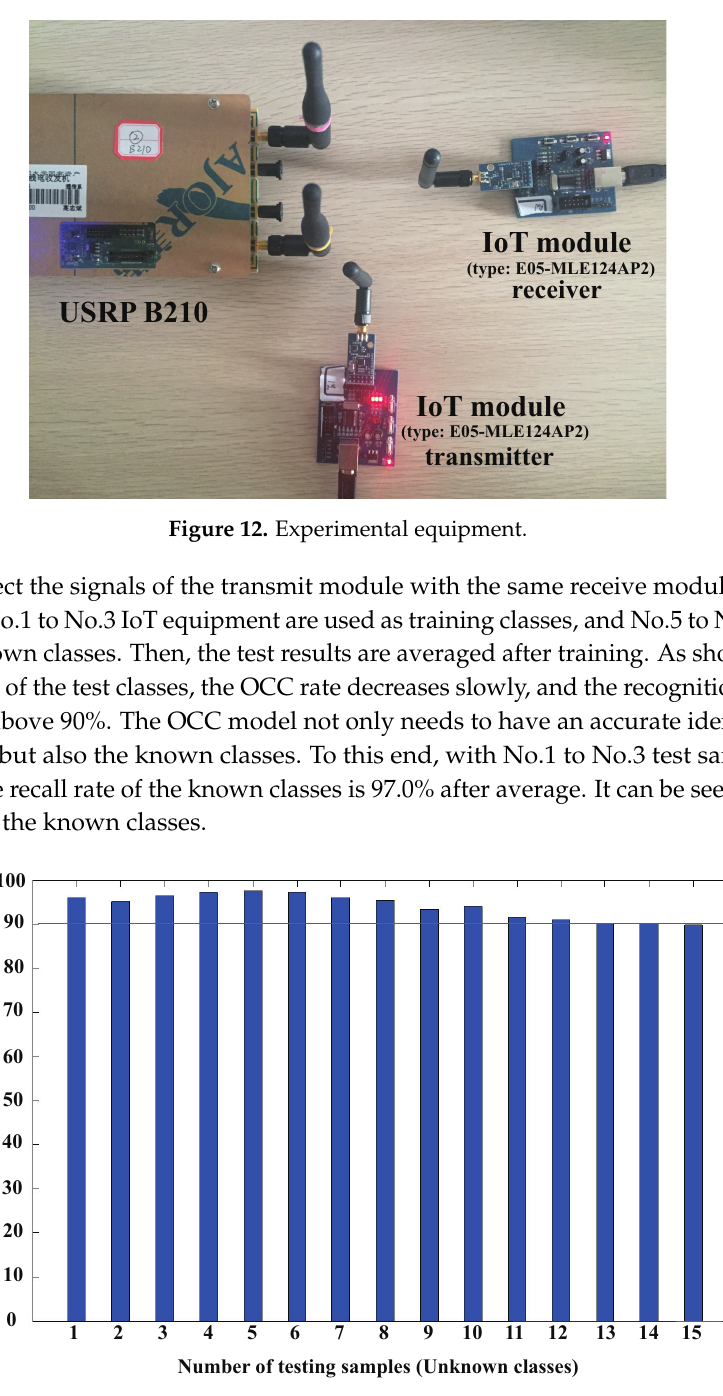
Figure 13. Result of the OCC-GAN